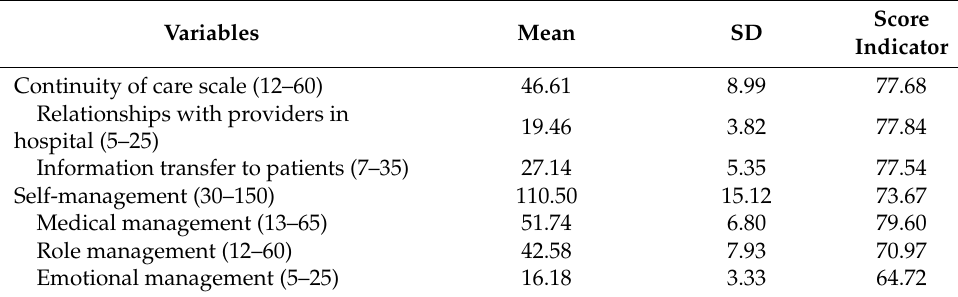
Table 2. The continuity of care and self-management of the participants ( N =